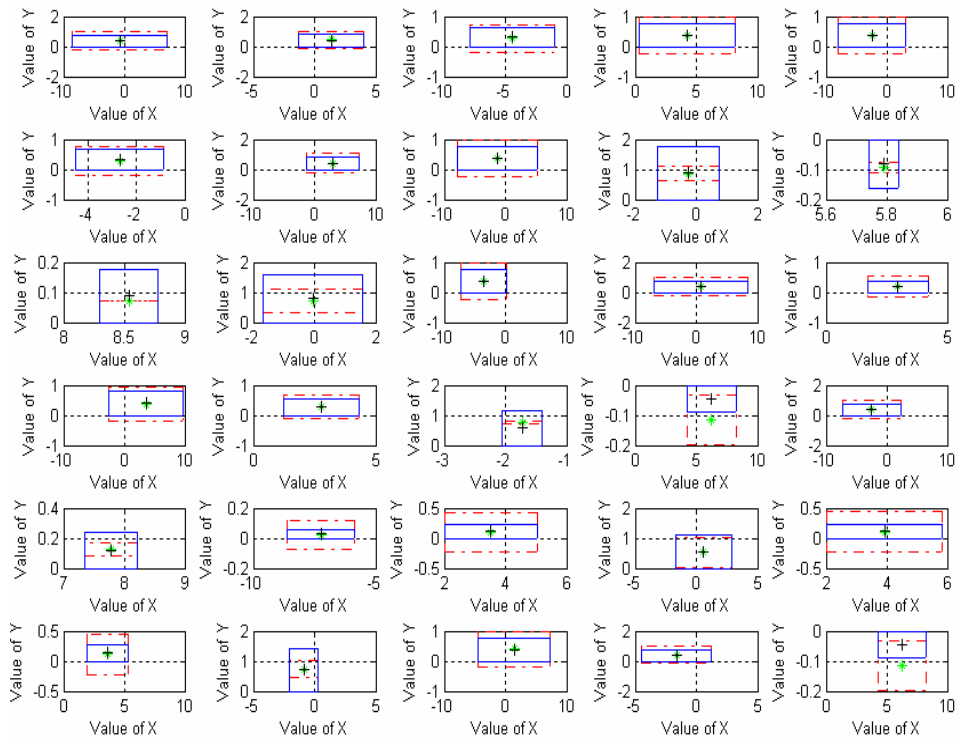
Fig.4 This is comparisons between predicted intervals and real ones used by Gabor